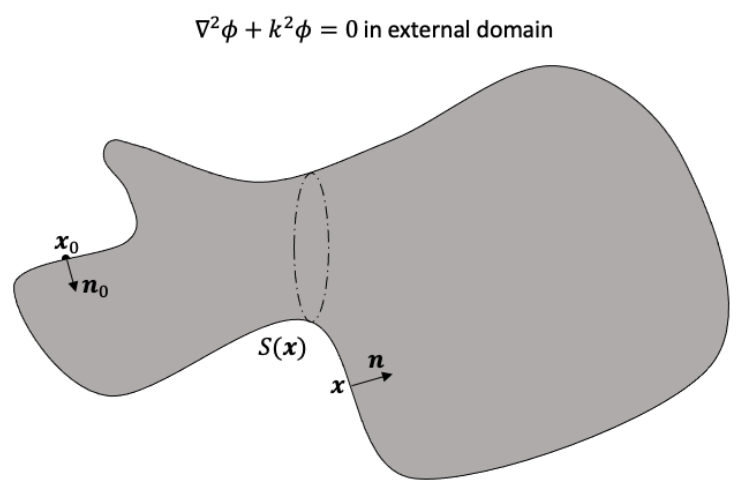
Figure 1. Sketch of the 3D object bounded by the closed surface S and surrounded by an infinite external domain. The position vectors x and x 0 are also indicated, together with the normal vectors n and n 0 , which are pointing out of the external